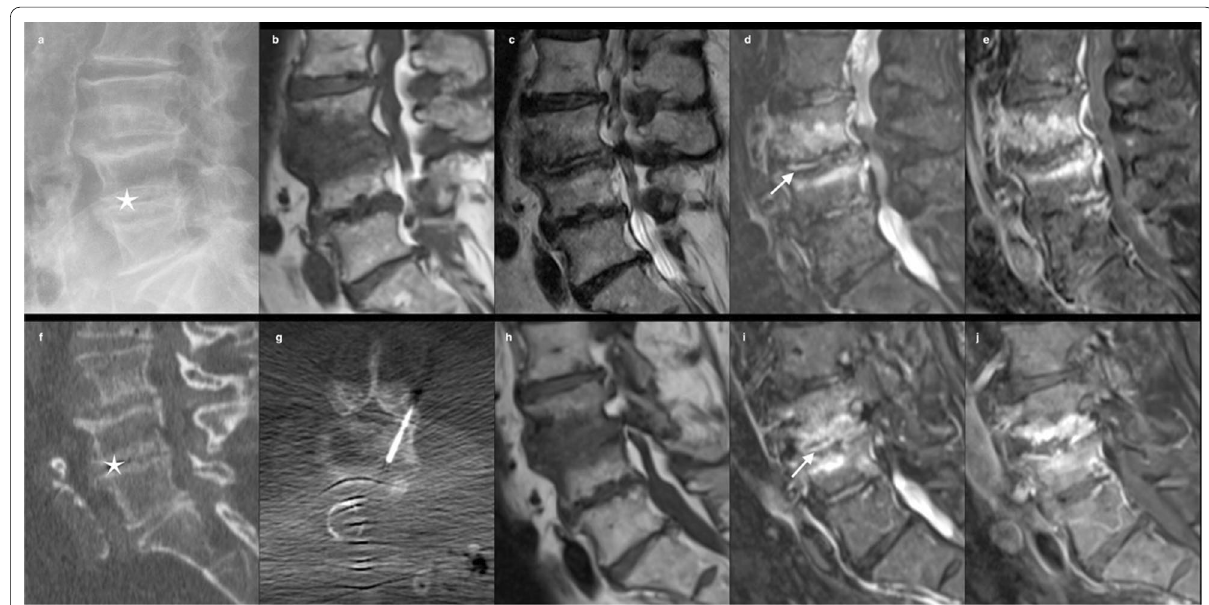
Fig. 1 68-year-old male with increasing back pain referred for pathologic confirmation and treatment of spondylodiscitis. Sagittal XR ( a ), Sagittal T1 ( b ), T2 ( c ), STIR ( d ) and T1 Fatsat after gadolinium R1 point 5 ( e ) confirm edema-type enhancing marrow signal abnormalities as well as disc hyperintensity (arrow), and narrowed L3–L4 space without disc enhancement. Following sagittal CT ( f ) R1 point 6 confirms the absence of endplates destruction and that the hypersignal on the underlying disc (L4–L5) corresponds to the vacuum phenomenon (star), biopsy performed under CT guidance ( g ) was negative. At 3 months, MRI control on sagittal T1 ( h ), STIR ( i ) and after contrast ( j ) shows stability of disco-vertebral features